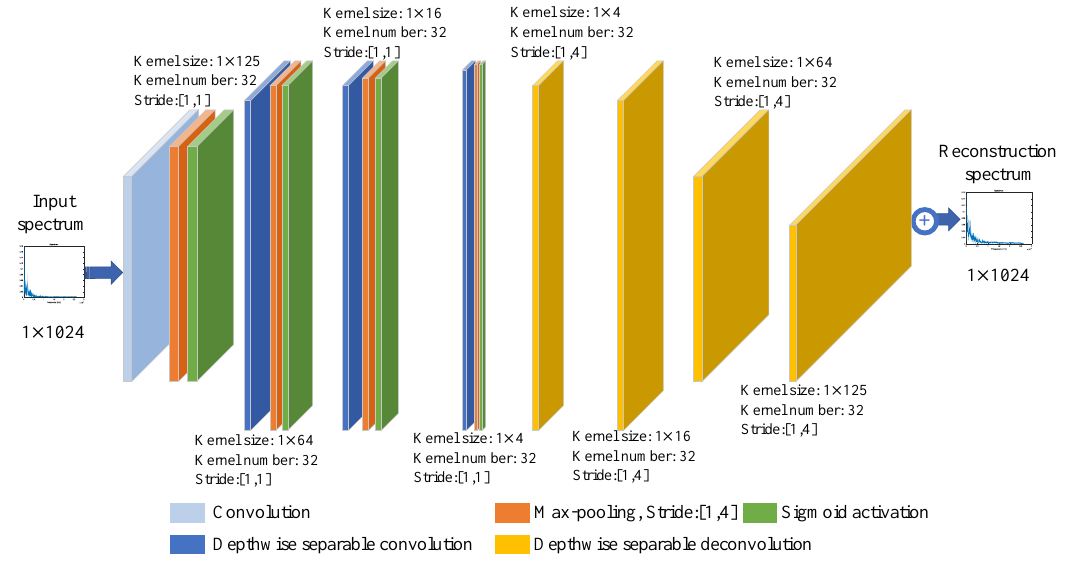
Figure 3. The structure of the hierarchical